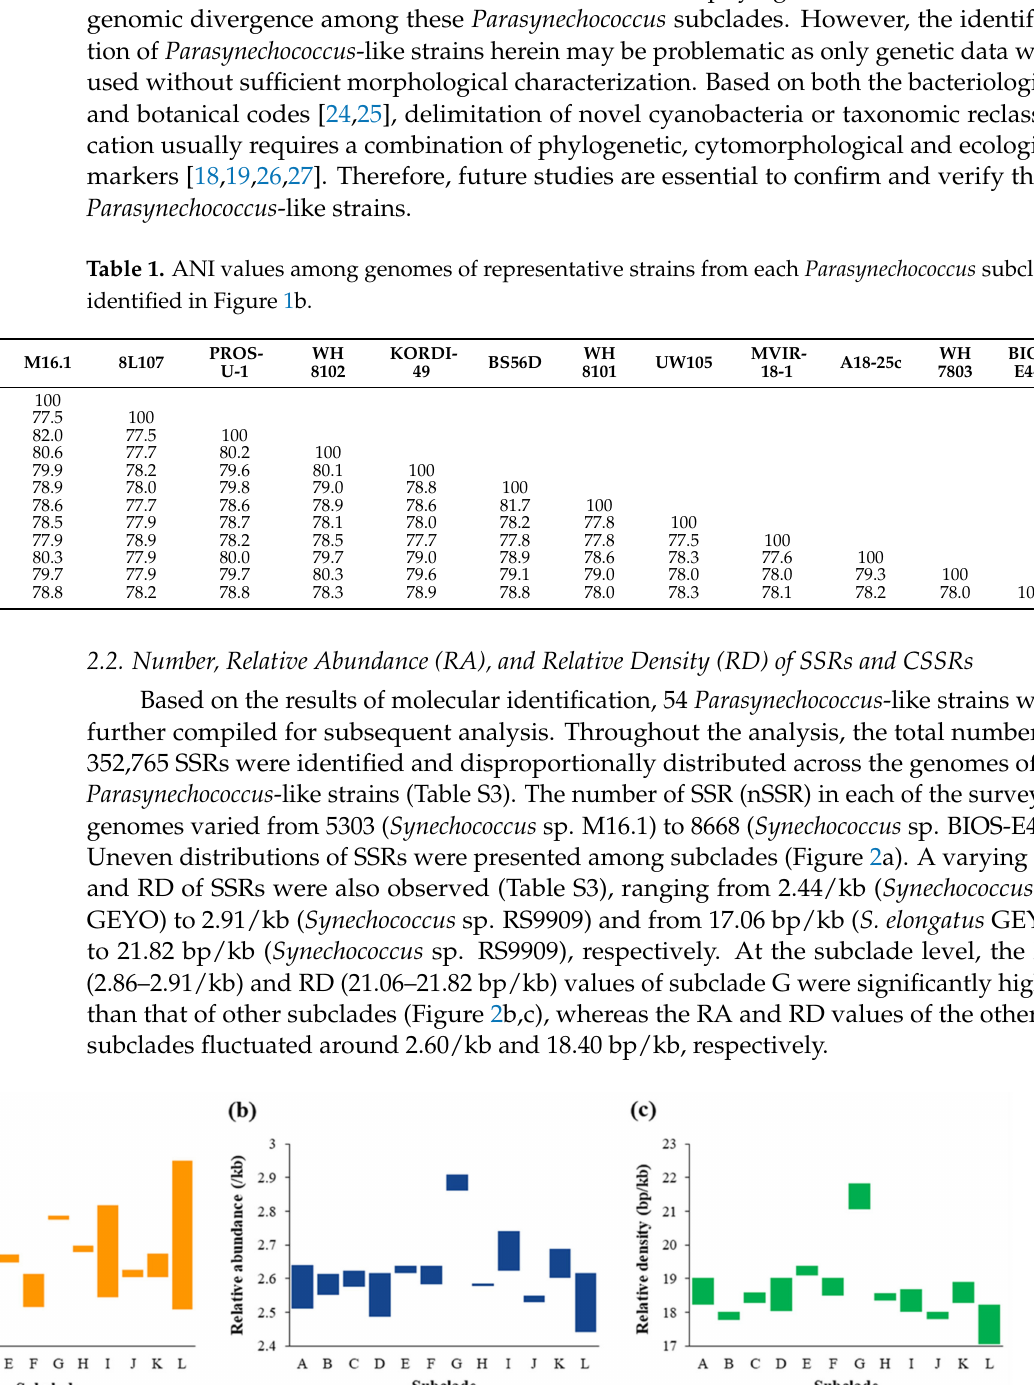
Table 1. ANI values among genomes of representative strains from each Parasynechococcus subclade identified in Figure 1b.